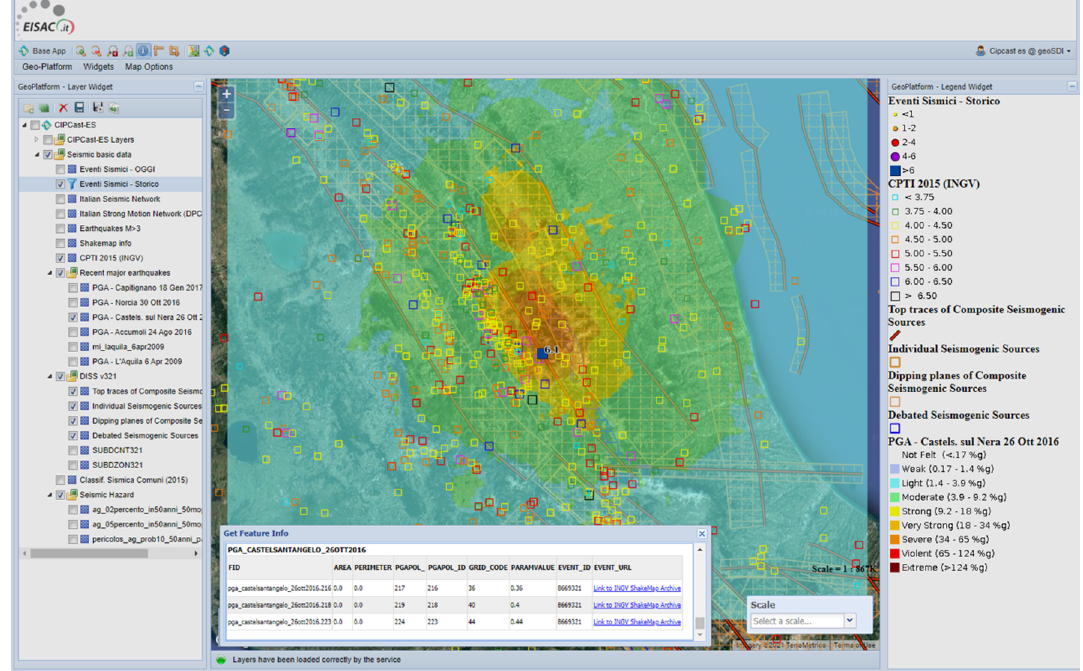
Figure 7. ARCH DSS screenshot representing data from geodatabases of: seismogenic sources; M W > 3 earthquake events; INGV ground shaking map of the 26th October 2016 “ Castel Sant’Angelo sul Nera ” Mw = 5.4 earthquake.